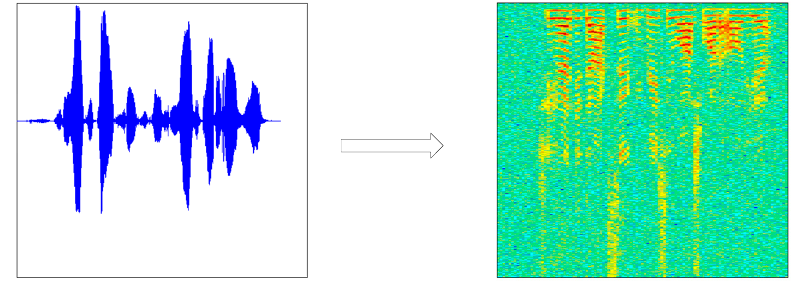
Figure 7. The speech contained in the TIMIT dataset and the corresponding spectrogram.